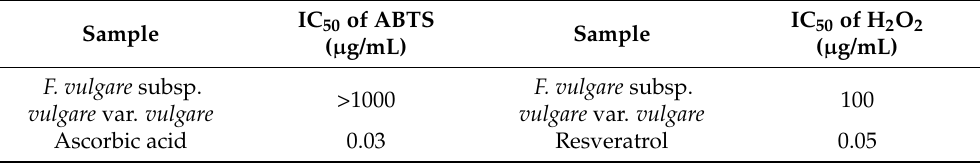
Table 2. Representation of the IC 50 : Inhibiting Concentration Free Radical at 50%. ABTS: 2,20-azino-